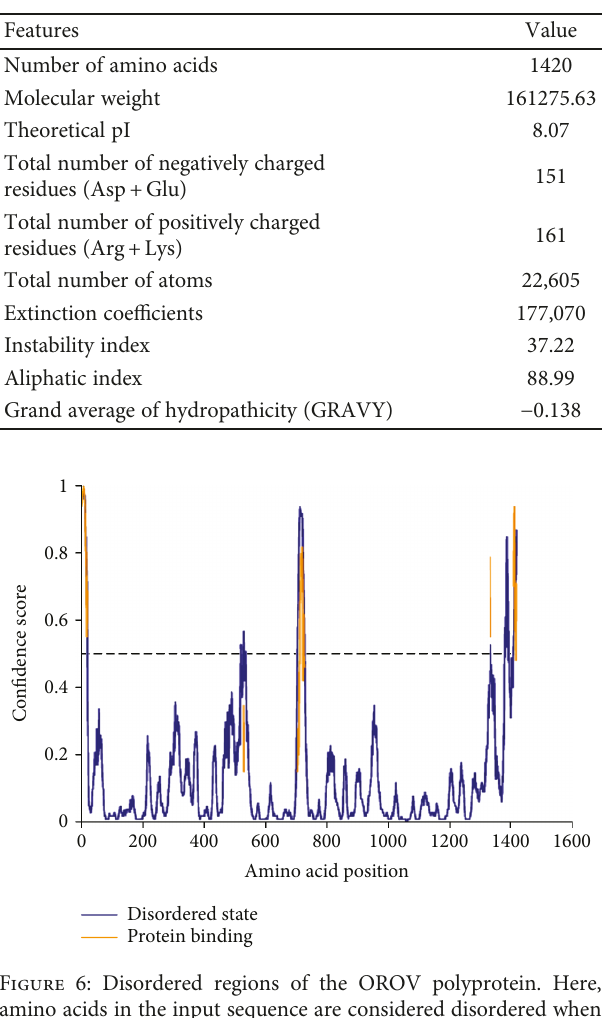
Table 7: Di ff erent physicochemical properties of the Oropouche virus (OROV) polyprotein.